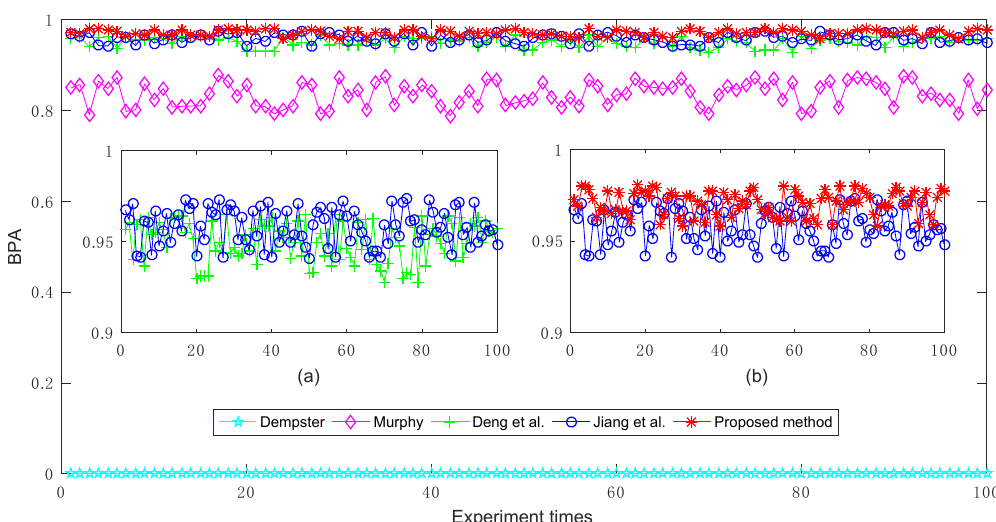
Figure 3. The comparisons of target a ’s BPAs obtained by different combination methods where the multiple BPAs are generated randomly 100 times. ( a ) The comparisons of Deng et al.’s combination method and Jiang et al.’s combination method; ( b ) The comparisons of Jiang et al.’s combination method and the proposed method.